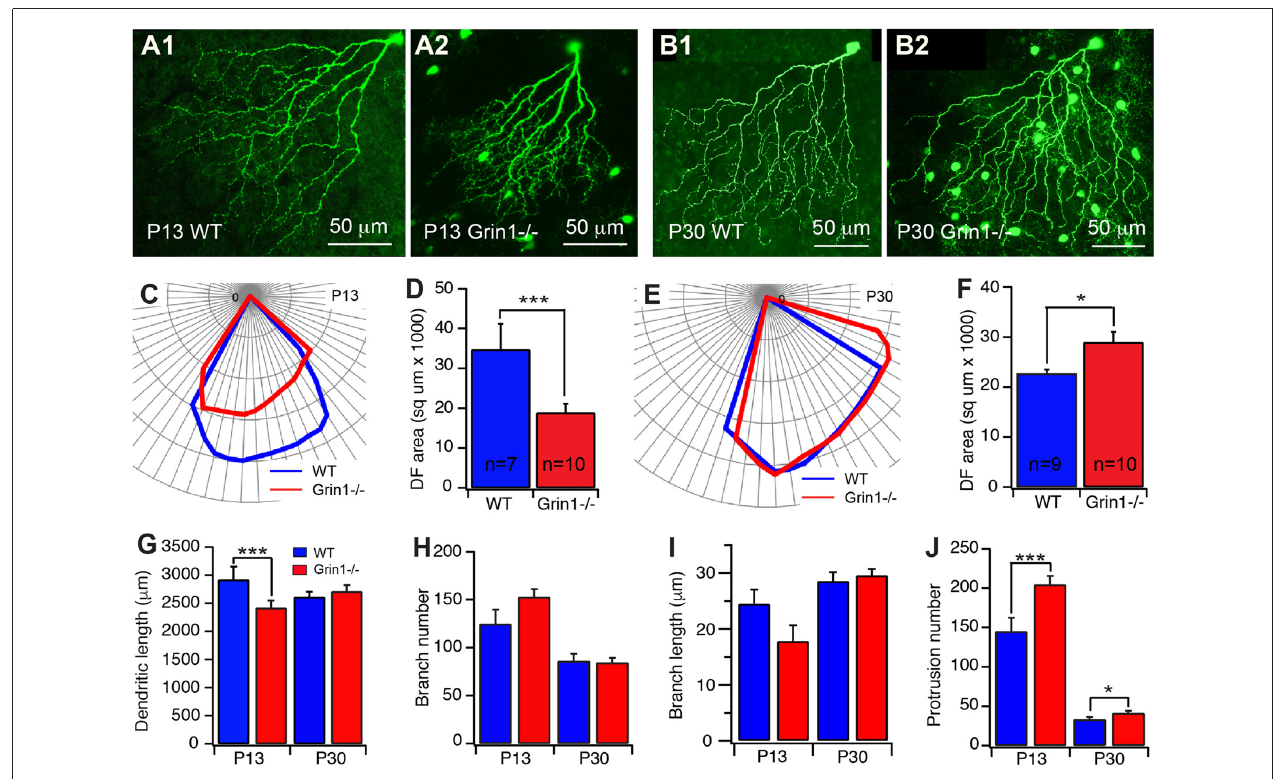
FIGURE 5 | Cell type specific mutation of N-methyl-D-aspartate receptor (NMDAR) retarded the developmental refinement of J-RGC dendrites. The dendritic patterns of J-RGCs were quantitatively analyzed at the ages of P13 and P30 of JamB-CreER:Thy1-YFP mice (WT) and JamB-CreER:Thy1-YFP:Grin1-/- mice (Grin1-/-). (A) Representative maximum projections of confocal images of J-RGCs from a P13 JamB-CreER:Thy1-YFP mouse (A1) and a P13 JamB-CreER:Thy1-YFP:Grin1-/- mouse (A2) . (B) Representative maximum projections of confocal images of J-RGCs from a P30 JamB-CreER:Thy1-YFP mouse (B1) and a P30 JamB-CreER:Thy1-YFP:Grin1-/- mouse (B2) . (C) The polar plots of the DFs of the J-RGCs shown in ( A1 ; blue) and ( A2 ; red). (D) The average sizes of DFs of J-RGCs of JamB-CreER:Thy1-YFP mice (2 mice, 7 cells) and JamB-CreER:Thy1-YFP:Grin1-/- mice (3 mice, 10 cells) at P13. (E) The polar plots of the DFs of the J-RGCs shown in panels B1 (blue) and B2 (red). (F) The average sizes of DFs of J-RGCs of JamB-CreER:Thy1-YFP mice (3 mice, 9 cells) and JamB-CreER:Thy1-YFP:Grin1-/- mice (3 mice, 10 cells) at P30. (G) The average total length of dendrites of J-RGCs of JamB-CreER:Thy1-YFP mice and JamB-CreER:Thy1-YFP:Grin1-/- mice at P13 and P30. (H) The average number of dendritic branches of J-RGCs of JamB-CreER:Thy1-YFP mice and JamB-CreER:Thy1-YFP:Grin1-/- mice at P13 and P30. (I) The average length of dendritic branches of J-RGCs of JamB-CreER:Thy1-YFP mice and JamB-CreER:Thy1-YFP:Grin1-/- mice at P13 and P30. (J) The average number of dendritic protrusions of J-RGCs of JamB-CreER:Thy1-YFP mice and JamB-CreER:Thy1-YFP:Grin1-/- mice at P13 and P30. ∗ P < 0.05; ∗∗ P < 0.01; and ∗∗∗ P <